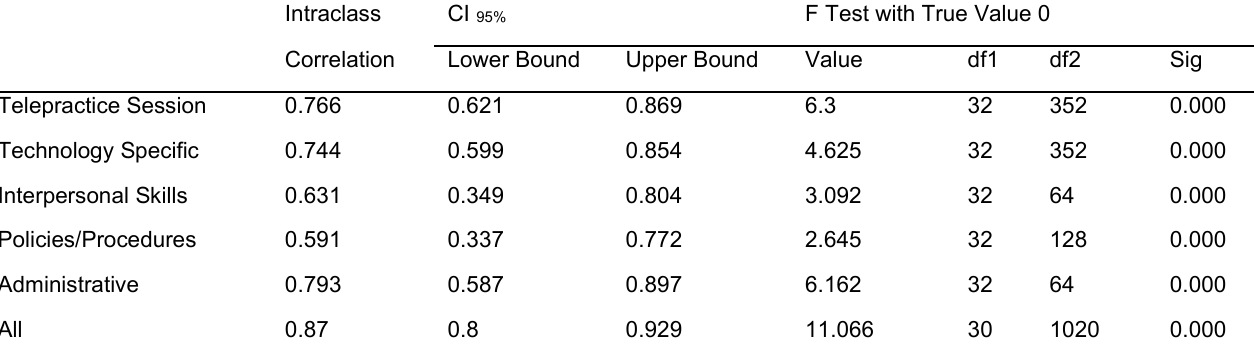
Whole Group ICC Calculation in SPSS Using Single-Rating, Absolute-Agreement, 2-Way Random-Effects Model, Average